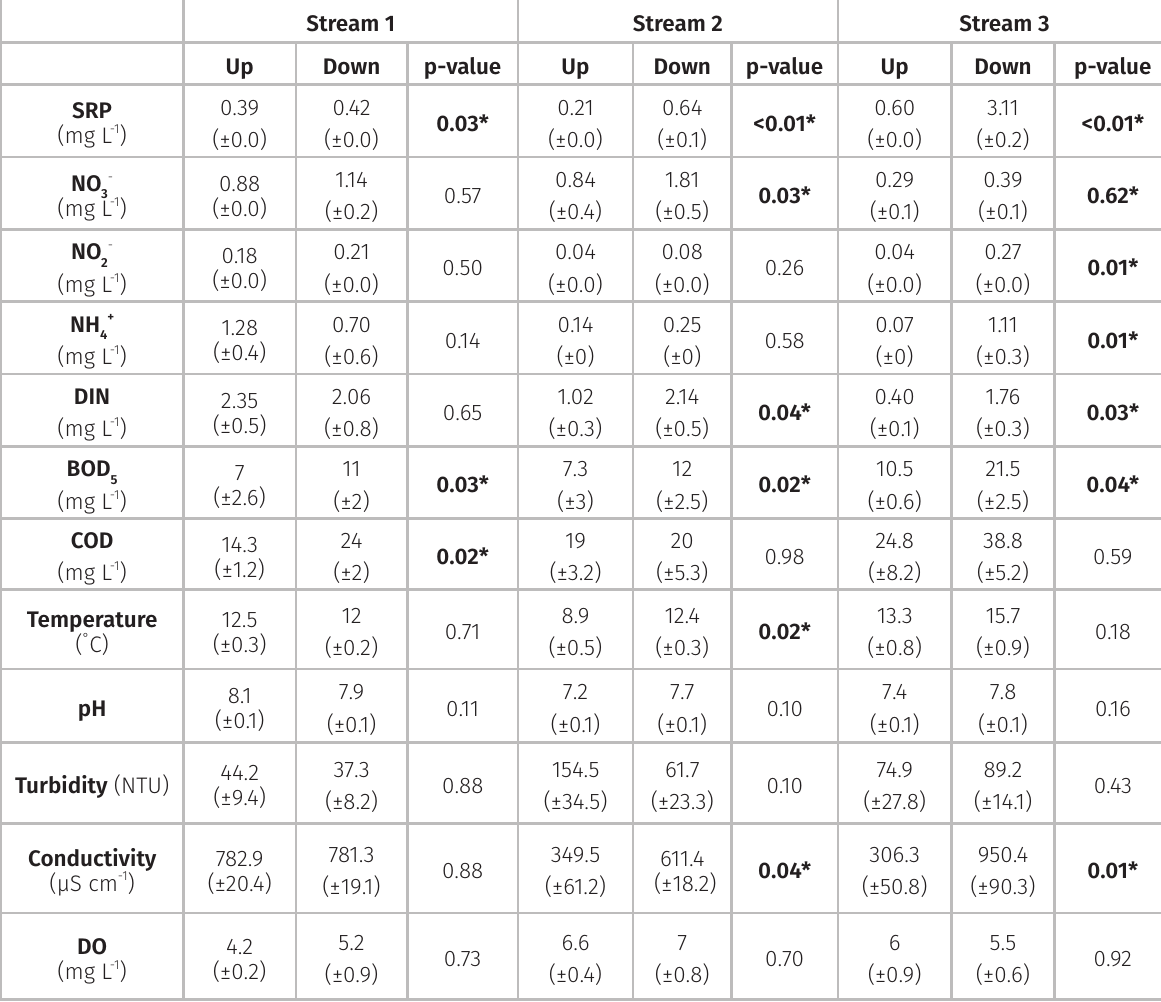
Table I. Mean (± Standard deviation) values for the physical-chemical data in the upstream ( Up ) and downstream ( Down ) sites of each stream (1, 2, 3). Significant differences between sites are marked with * (p-value <